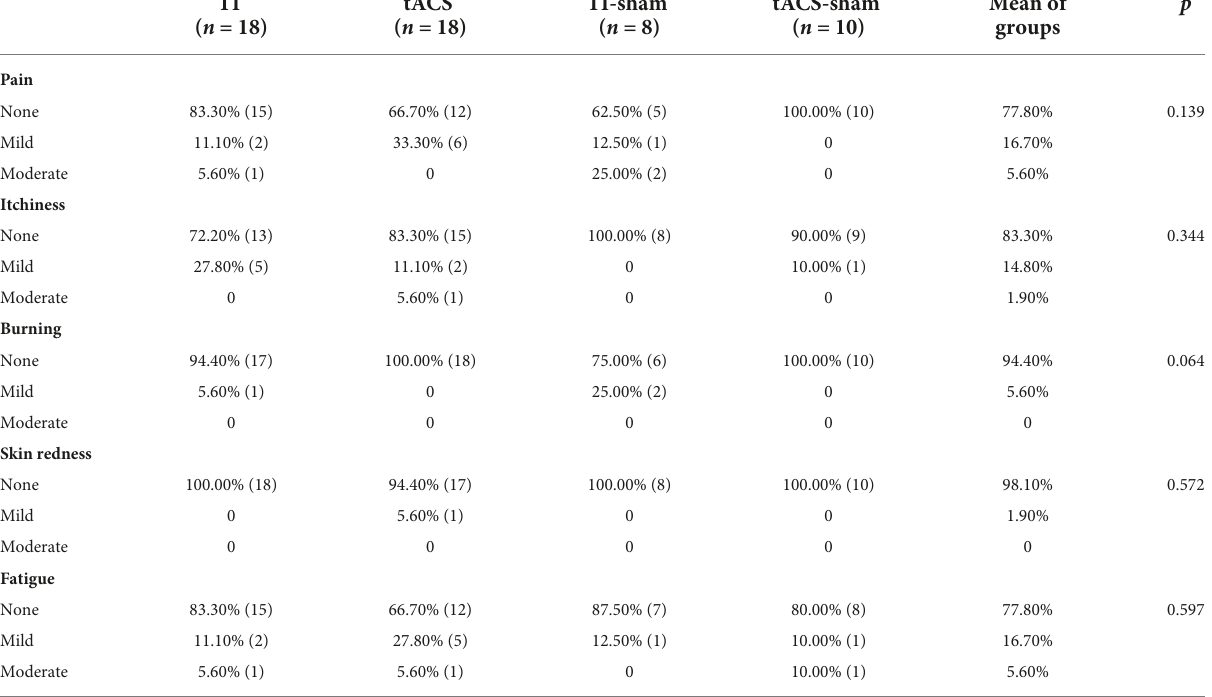
TABLE 2 Reported side effects in the four types of stimulation